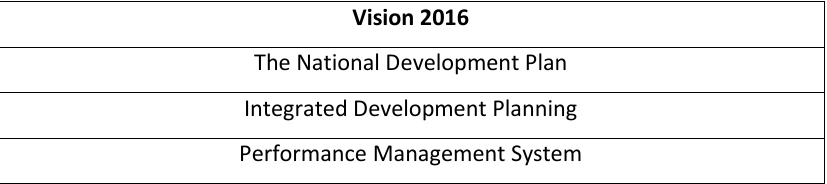
Table 4: Components of the National Development Planning Process in